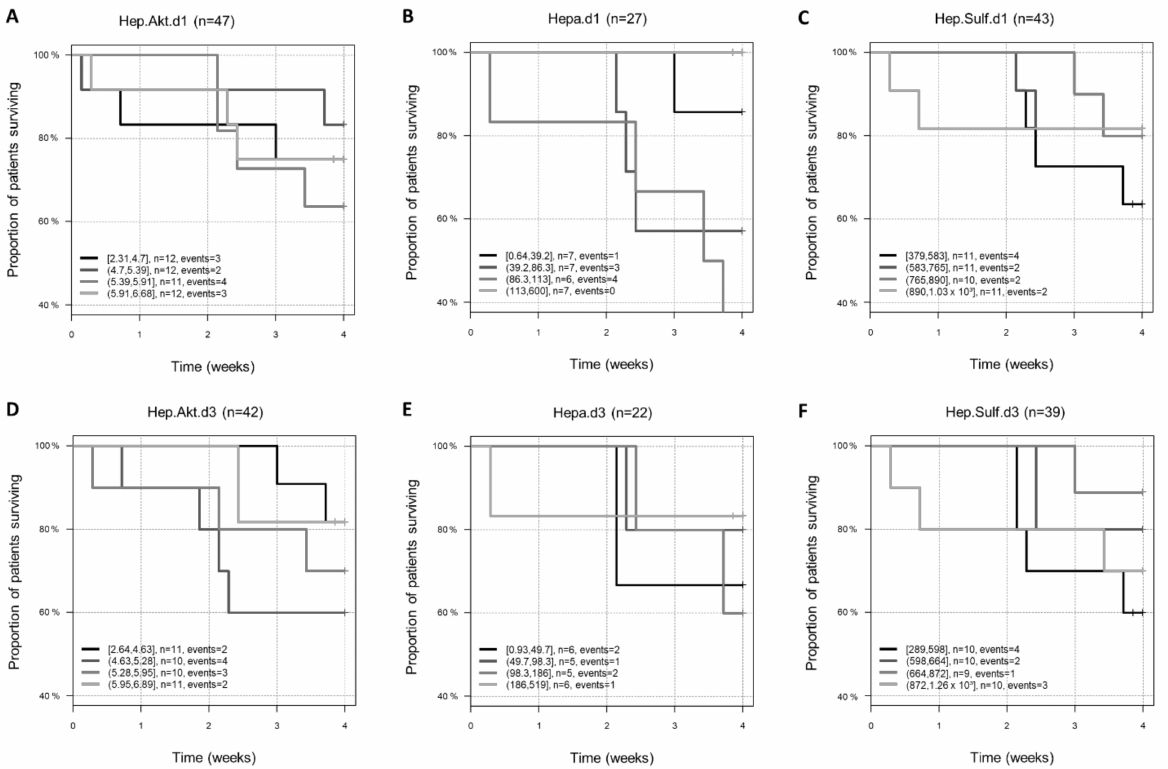
Figure 2. The relationship between heparan sulfate and heparanase serum levels as well as hep- aranase activity and the 28-day mortality. Presented are Kaplan–Meier plots for 28-day mortality for heparanase activity on ( A ) day 1 and ( D ) day 3 and heparanase level on ( B ) day 1 and ( E ) day 3 as well as the heparanase sulfate level on ( C ) day 1 and ( F ) day 3 of COVID-19 patients. Curves are plotted by quartiles. Hep.Akt.: heparanase activity; Hepa: heparanase; Hep.Sulf.: heparan